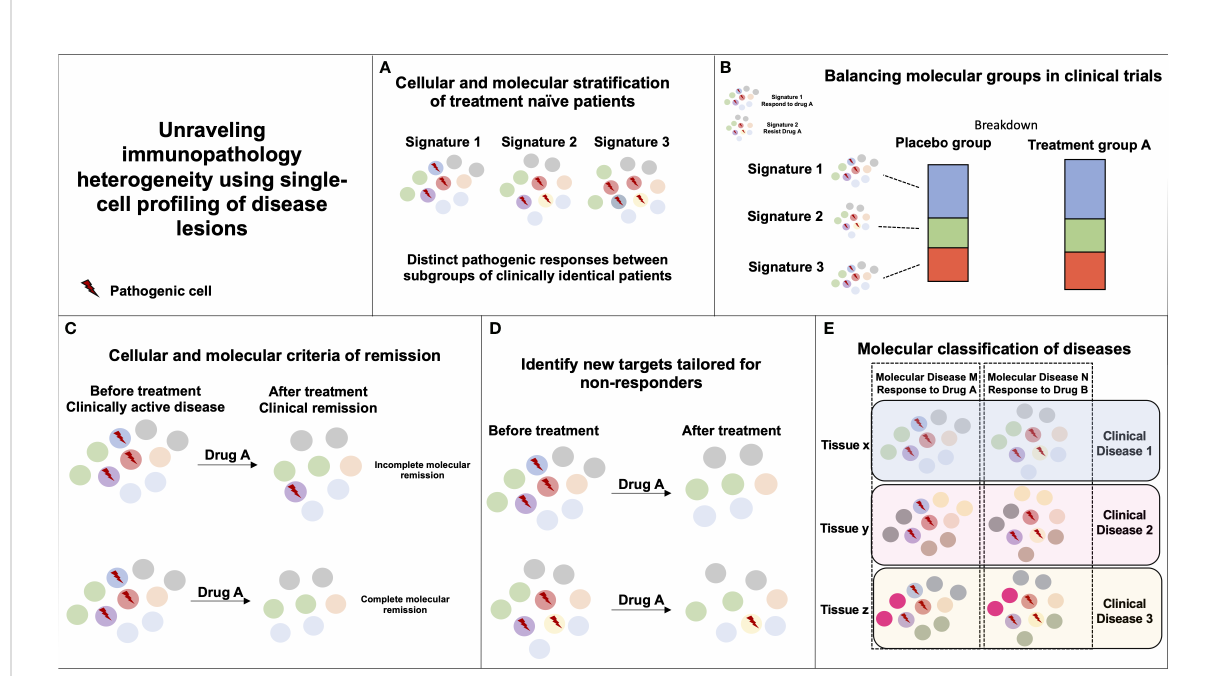
FIGURE 1 Unraveling immunopathology heterogeneity using single-cell pro fi ling of disease lesions. (A) The characterization of distinct immunopathogenic responses in lesional tissues between subgroups of clinically similar patients can help derive stratifying cellular and molecular signatures. (B) If two pathogenic responses are causing a similar clinical disease but only signature 1 is responding to Drug A, random or biased enrichment of signature 1 in Placebo vs. Drug A group could mislead to Drug A inef fi cacy in the disease. (C) Monitoring cellular and molecular responses in tissues during the course of treatment can help de fi ne molecular endpoints of remission in patients with clinically inactive disease. (D) Monitoring cellular and molecular responses in tissues during the course of treatment can help identify immune pathways unaffected by the drug that could be targeted by another therapy. (E) Similar immunopathogenic responses occurring in distinct tissues and diseases can be targeted by the same